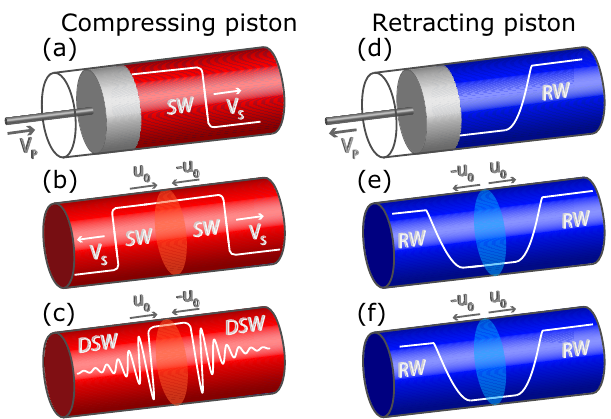
Fig. 1 Schematic of the physics and typical evolutions of classic vs. dispersive piston problems. a , b , c Shock wave dynamics for “ pushing" piston (white curves show qualitatively the density): ( a ) compressing piston producing a shock wave in an ideal (non-dispersive) fl uid; ( b ) shock- shock produced via stepwise initial velocity pro fi le (Riemann problem); ( c ) DSW-DSW via Riemann problem in a dispersive photon fl uid; d,e,f: Rarefaction wave dynamics for “ retracting" pistons: ( d ) single RW; ( e ) RW- RW from the Riemann problem; ( f ) similar RW-RW in a dispersive photon fl